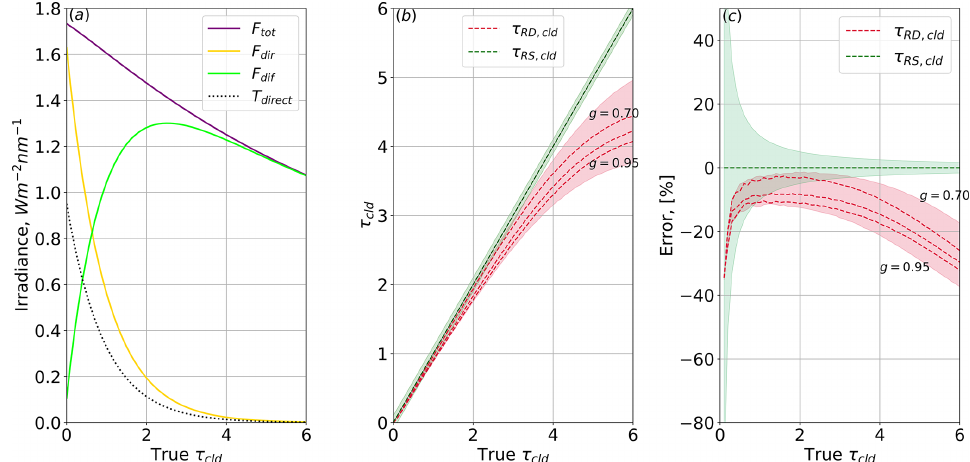
Figure 3. (a) Simulated 500nm irradiances at 4km altitude, with an ice cloud situated at 10km. Solar zenith angle is 20 ◦ ; ice crystal effective radius is 20µm. (b) Retrieval outputs with the simulated irradiances used as inputs. Error in F dir is 7.0%; error in DR is 0.5%. The uncertainty in retrieval output is represented by the shading. For RD, this uncertainty also reflects g values of 0.70, 0.85, and 0.95. (c) Percent error in the two retrieval methods when compared to the true cloud optical